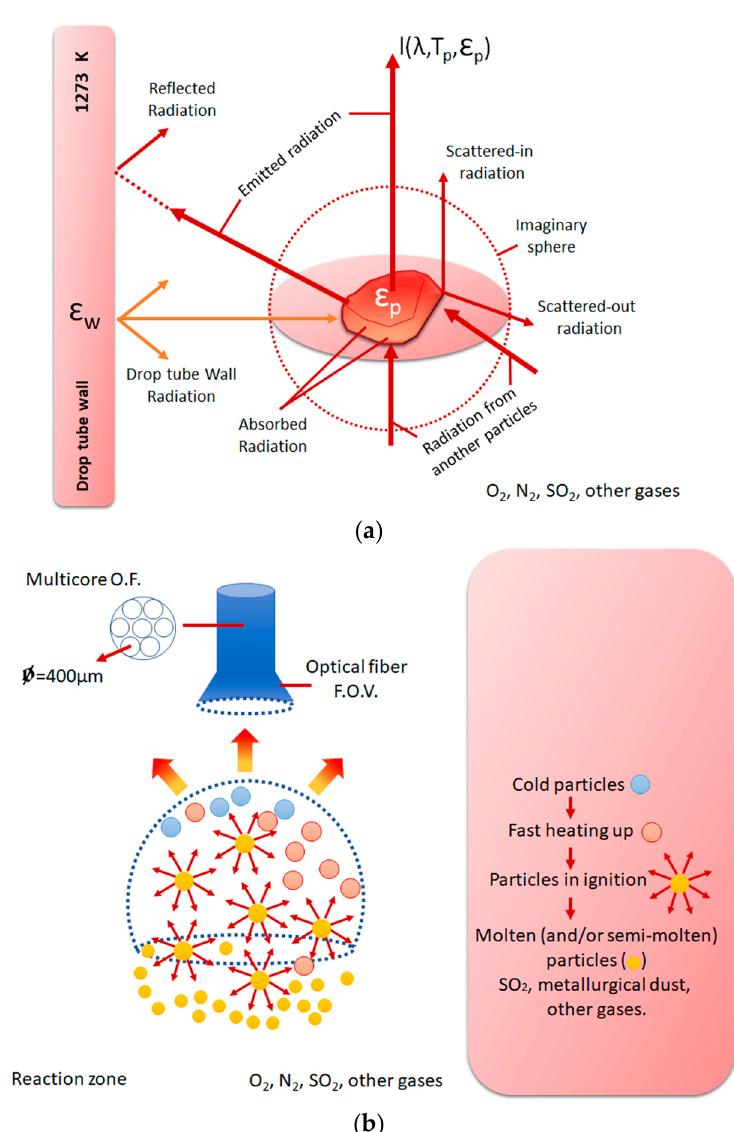
Figure 2. Radiometric measurement scheme and associated radiative processes: ( a ) single-heated particle radiative emission with its surroundings, in which the intensity I of the emitted radiation is a function of wavelength λ , particle temperature T p and particle emissivity ε p and ( b ) sensing scheme depicting the different particle states as they fall through the reaction zone (adapted from [8]).